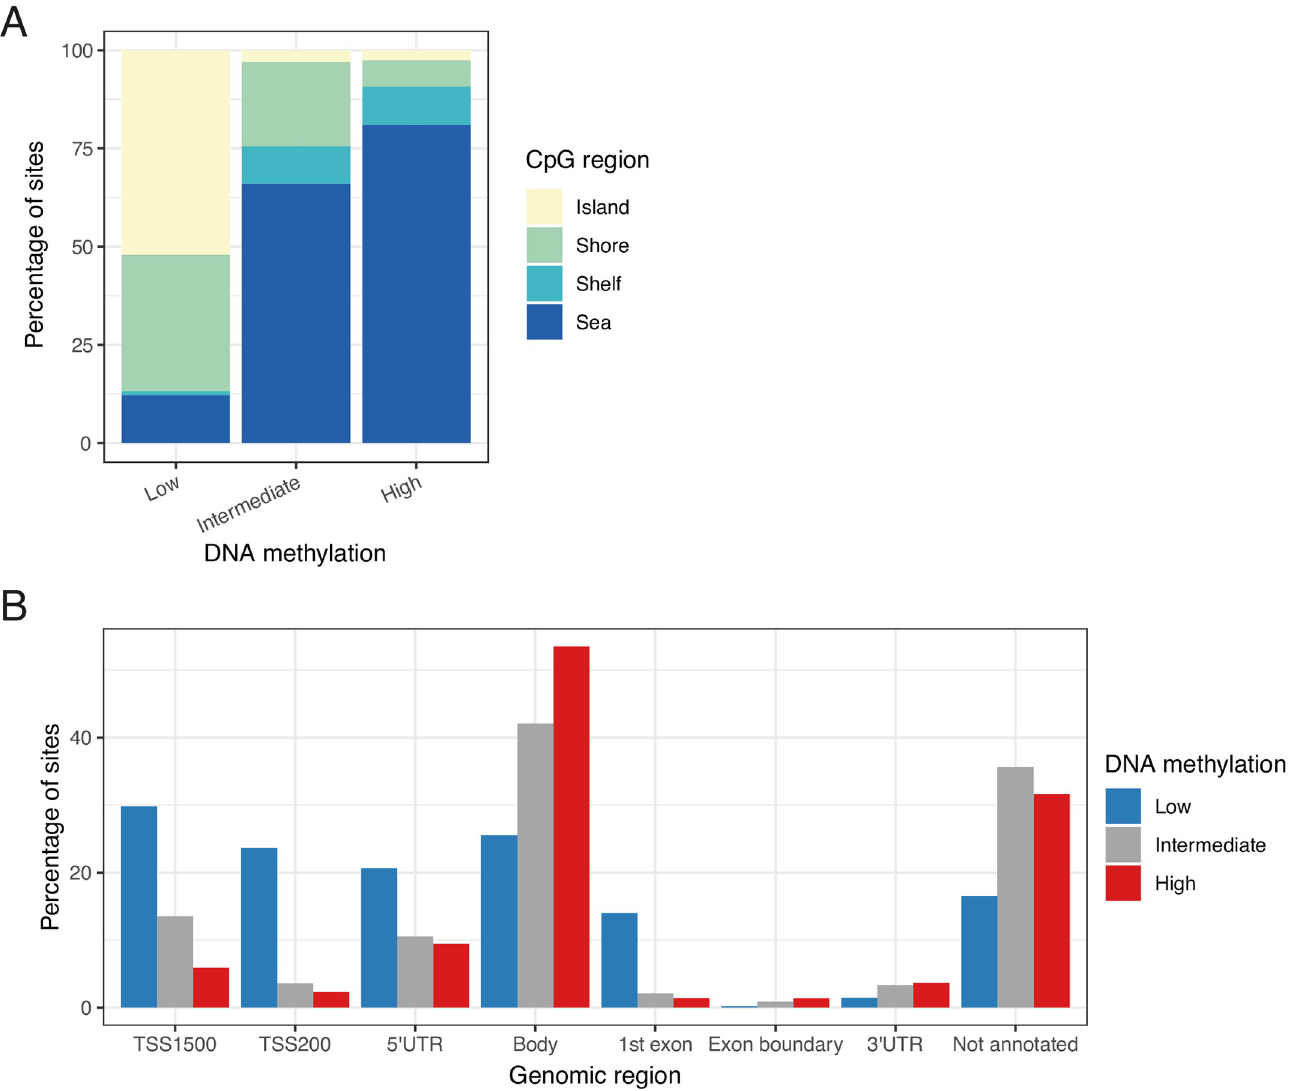
Fig 2. DNA methylation distribution of the human sperm DNA methylome. ( A ) The percentage of CpG sites that display low (median DNA methylation < 20%), intermediate (40–60% median DNA methylation) and high (median DNA methylation > 80%) levels of DNA methylation in spermatozoa are shown according to CpG region. ( B ) The percentage of CpG sites that display low, intermediate and high levels of DNA methylation in spermatozoa are shown according to their genomic region. TSS : transcription start site , UTR : untranslated region